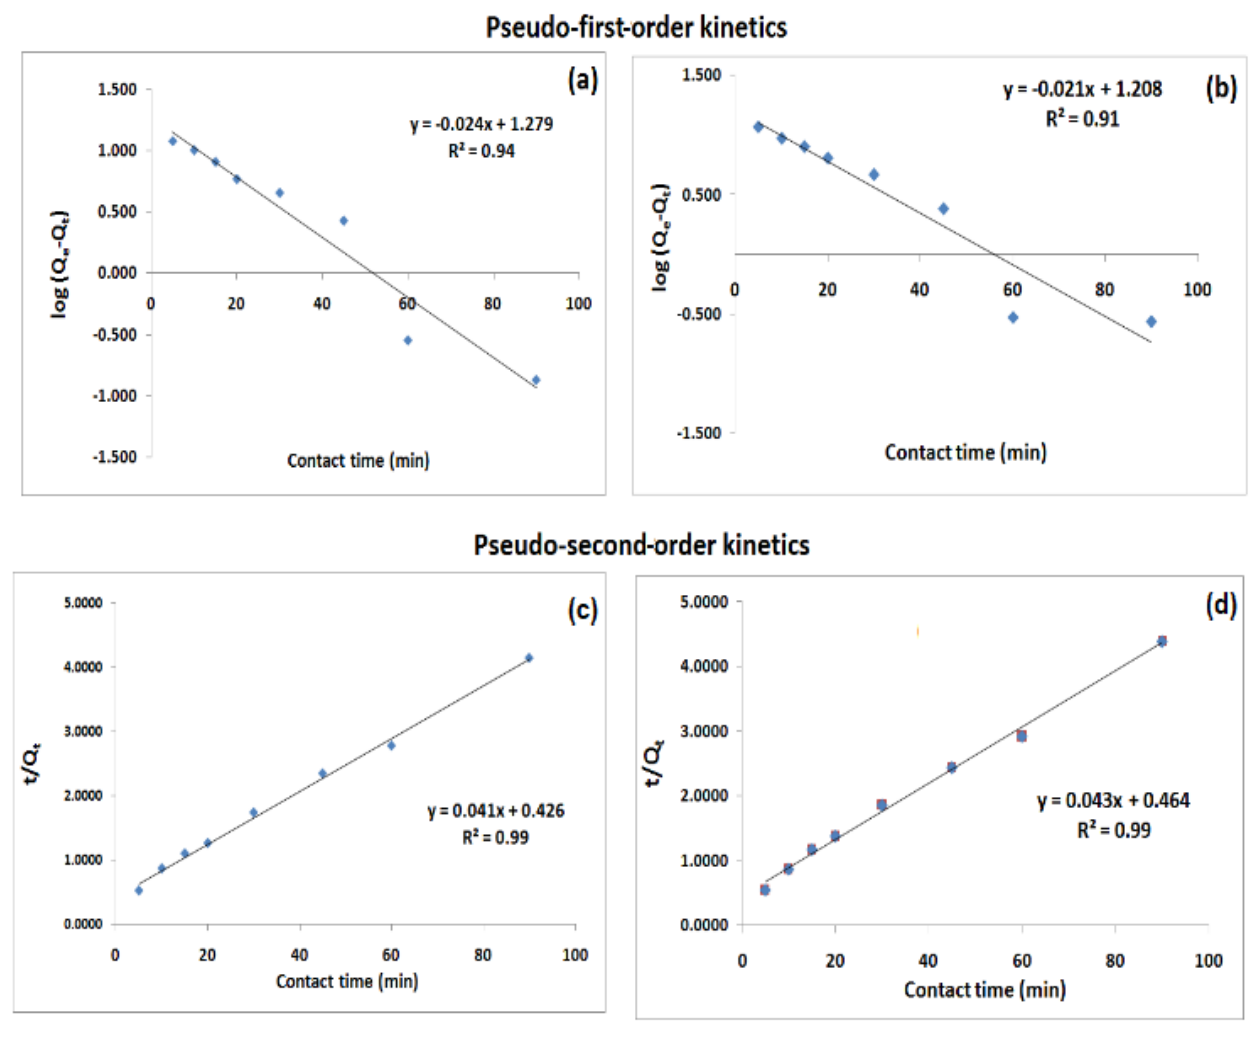
Table 2. Kinetics of adsorption.